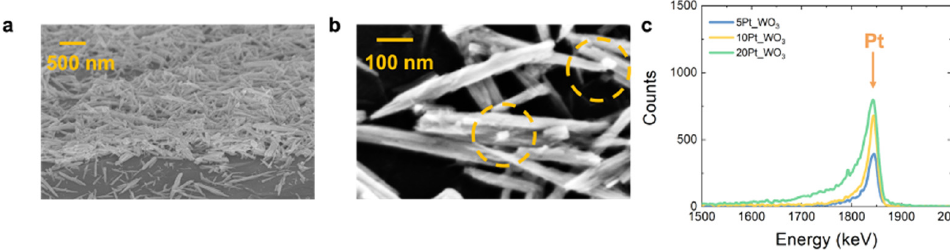
glomeration of nanorods; ( b ) low-magnification SEM images of WO 3 nanorods decorated with Pt nanoparticles (highlighted in orange circles); ( c ) RBS spectrum of Pt nanoparticles on a flat Si substrate for the 5Pt_WO 3 , the 10Pt_WO 3 , and the 20Pt_WO 3 electrodes (blue, yellow, and green lines, respectively).